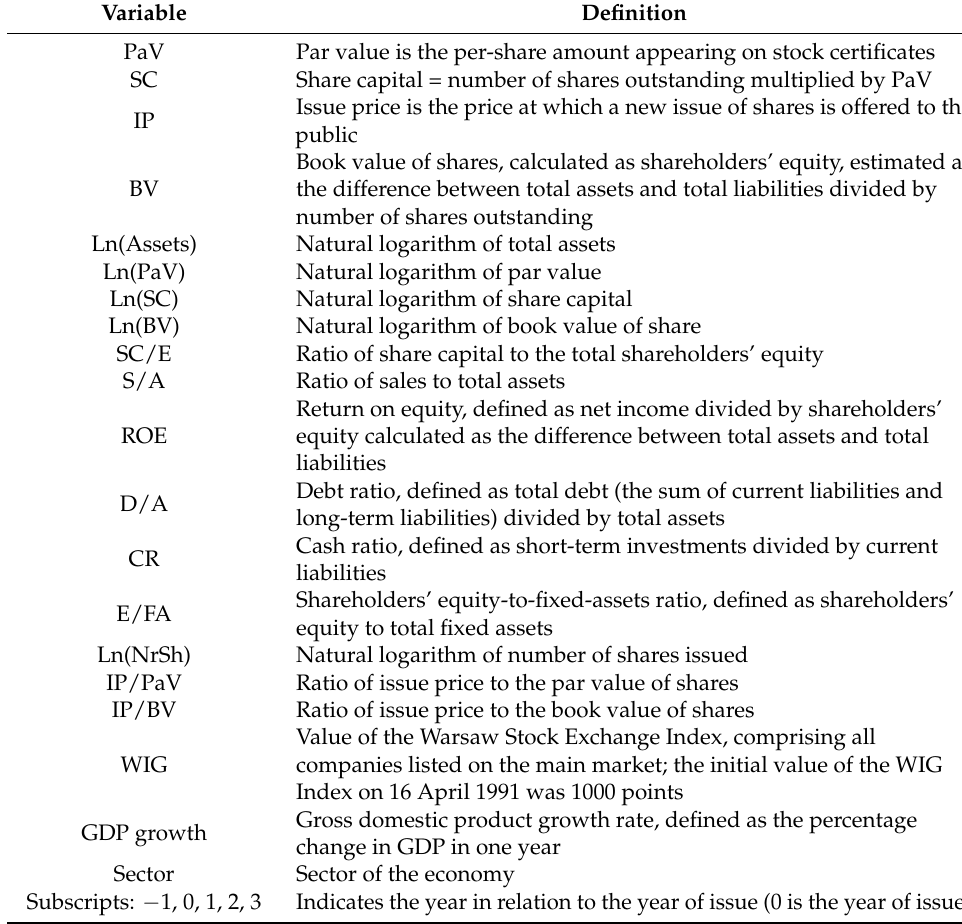
Table 3. Variable